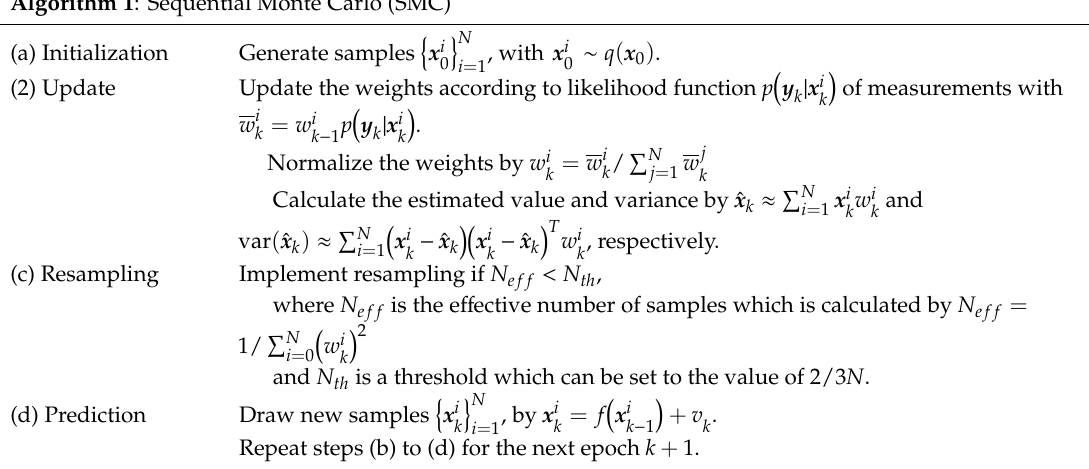
Algorithm 1 : Sequential Monte Carlo